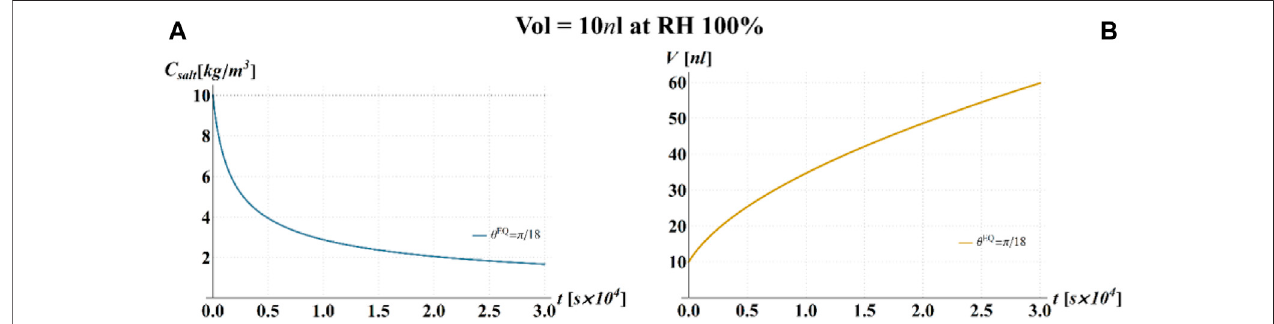
FIGURE 4 | Results of model calculations of the evaporation process of a sessile drop of aqueous solution with a starting volume of 10 nL, at an RH (cid:2) 100%, in termsoftimeevolutionof (A) thesaltconcentration, C salt ,and (B) thevolume, V, for fl atsurfaceswithdifferentwettability,at T (cid:2) 25 ° C.Onlythecalculationsperformedfor an initial contact angle equal to π / 18 are presented since, for the cases θ EQ (cid:2) π / 6 , θ EQ (cid:2) π / 3 and θ EQ (cid:2) π / 2 , the condition for validity of Eq. 7 , that is, 0 < θ ( t ) ≤ π / 2 is not ful fi lled during the evolution of the drop within the selected time frame of the simulation (i.e., for the 10 nL droplet, it is set to 3 × 10 4 s and the contact angle approaching π / 2 at about 1 . 5 × 10 5 s